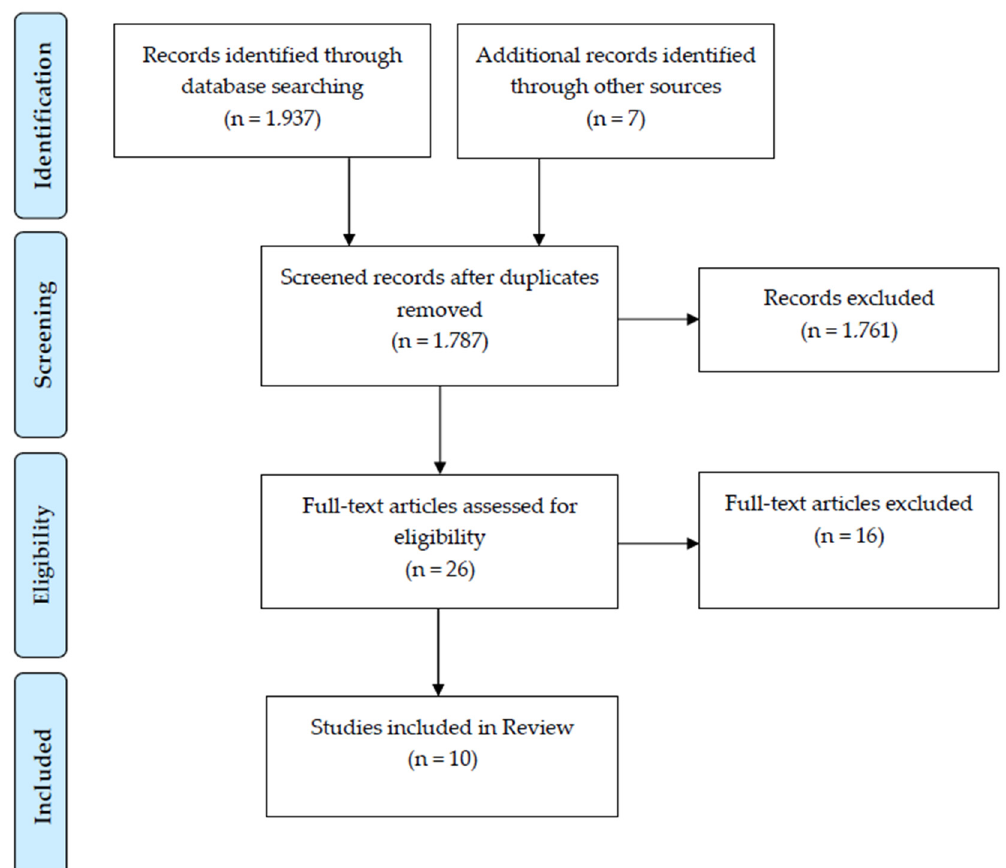
Table A1. Inclusion and exclusion criteria. Criterion